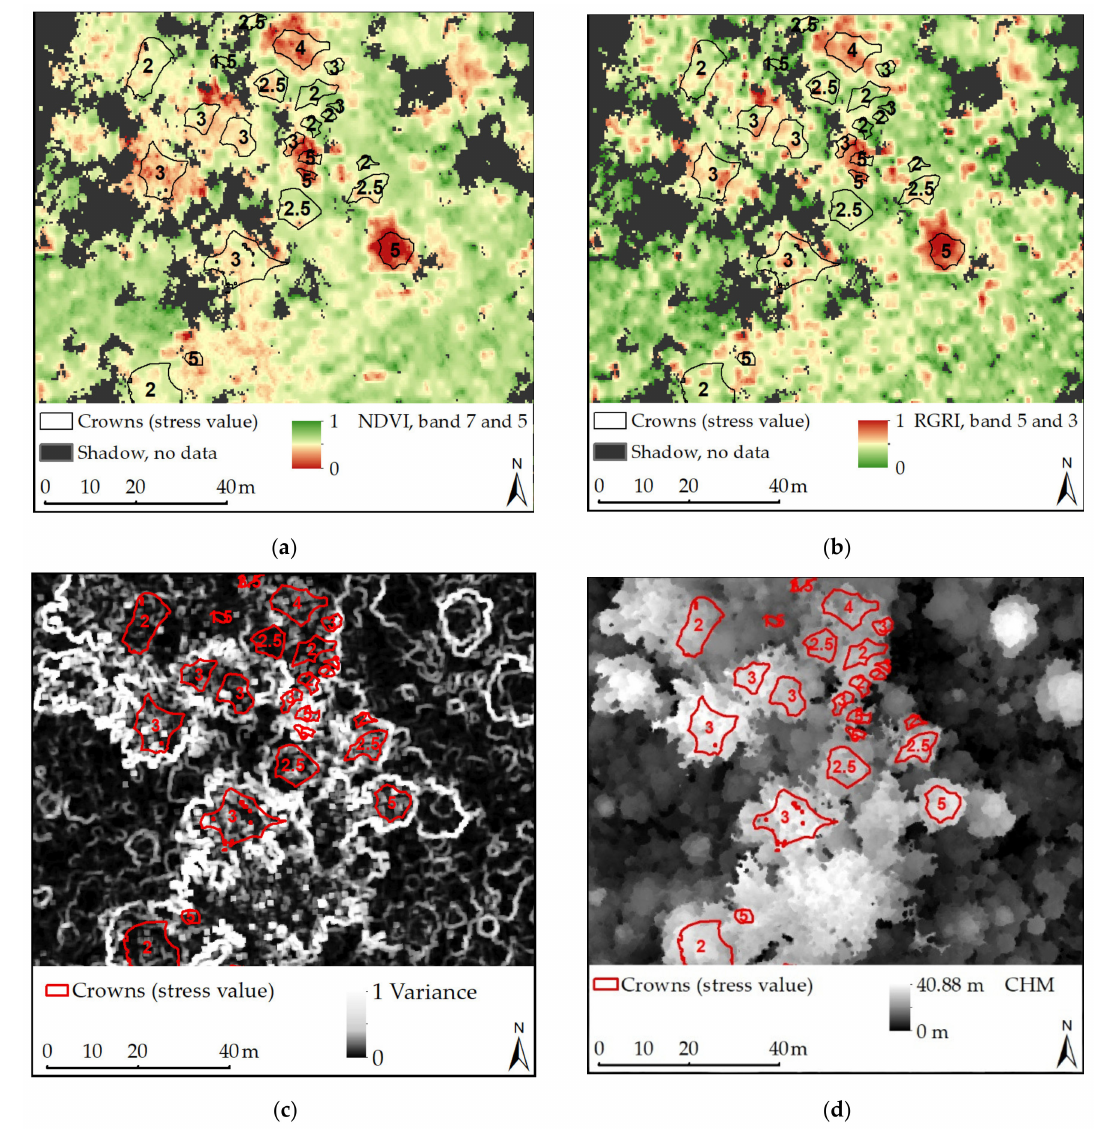
Figure 7. Raster datasets of selected attributes with reference crowns marked as red polygons and labelled stress symptom values. The images show a ( a ) normalised di ff erence vegetation index (NDVI) on red and NIR1 bands (NDVI_75), ( b ) the red-green ratio index (RGRI) on the red and green bands, ( c ) a variance raster for a 5 × 5 kernel on a crown height model (CHM), and ( d ) a CHM with a freeze distance of 1 m. The grey areas on the spectral rasters (a and b) mark shadows and no-data pixels that were masked out for the